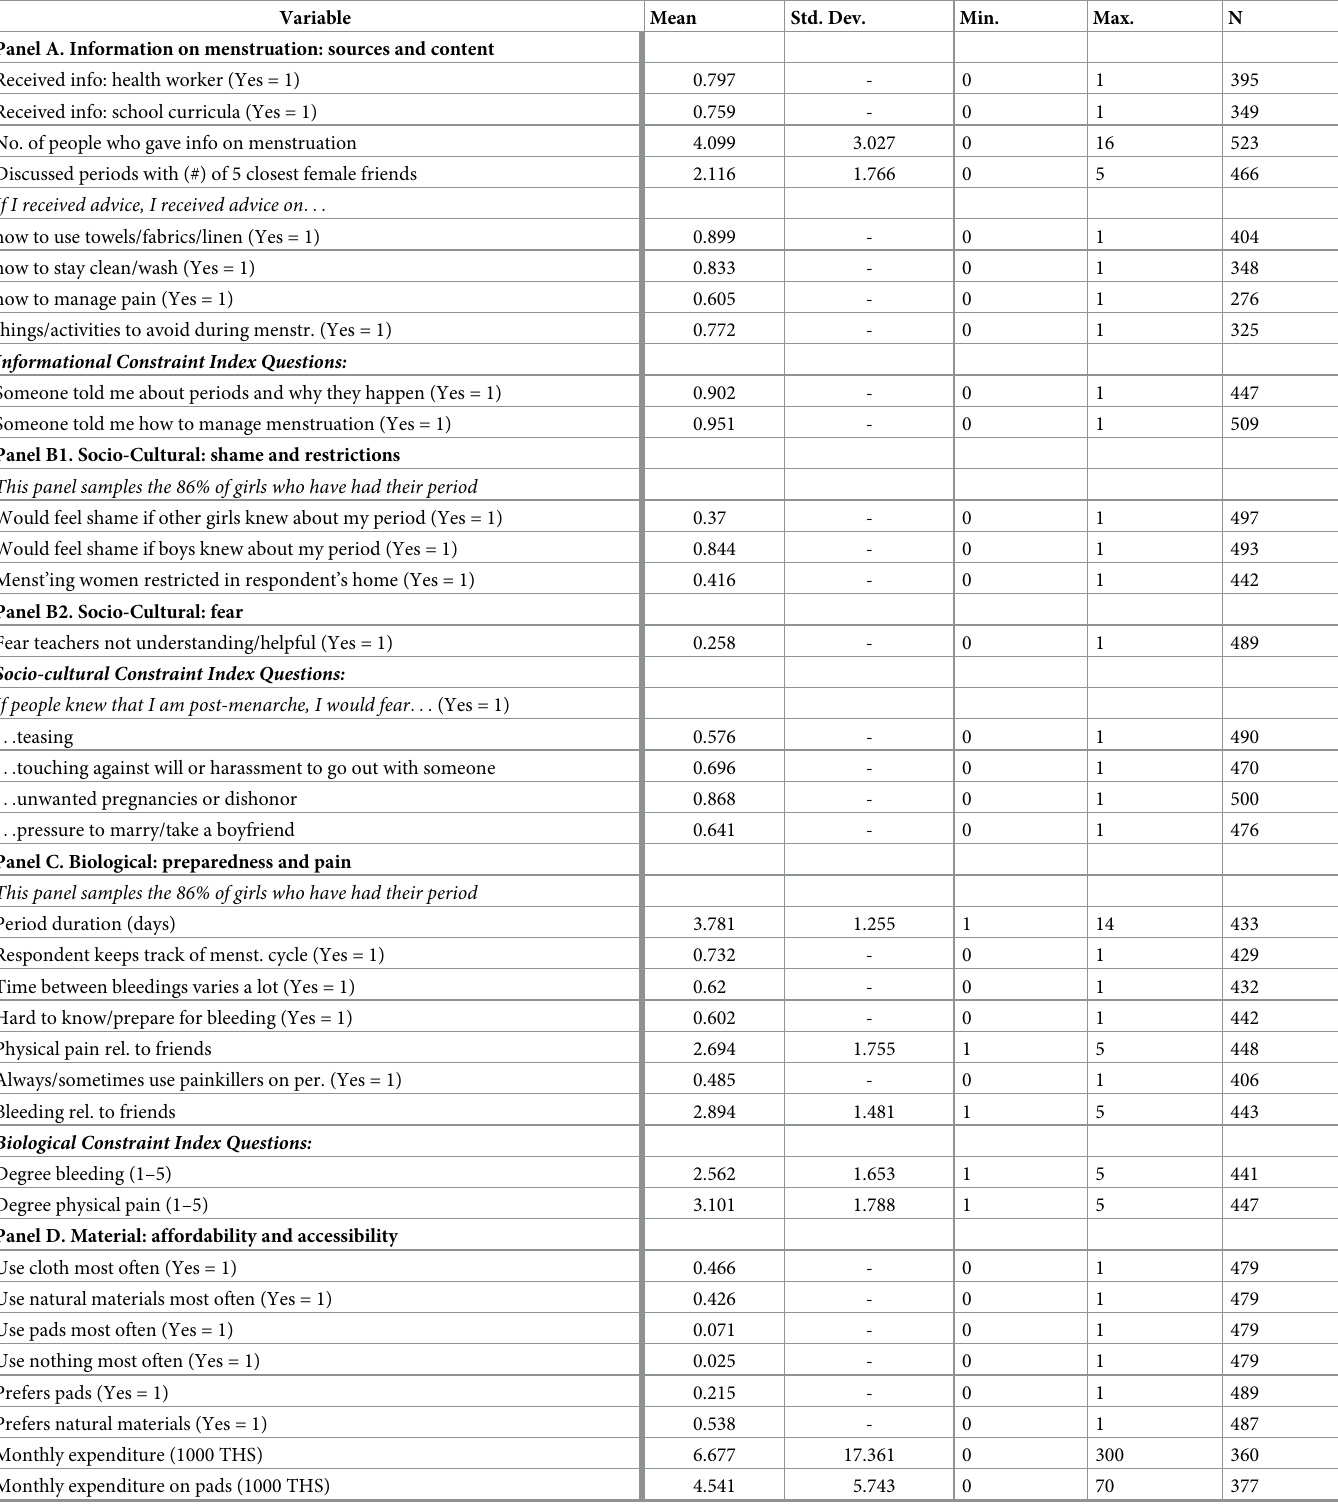
Table 2. Demographics and menstruation-related constraint indices. Variable Mean Std. Dev. Min. Max.